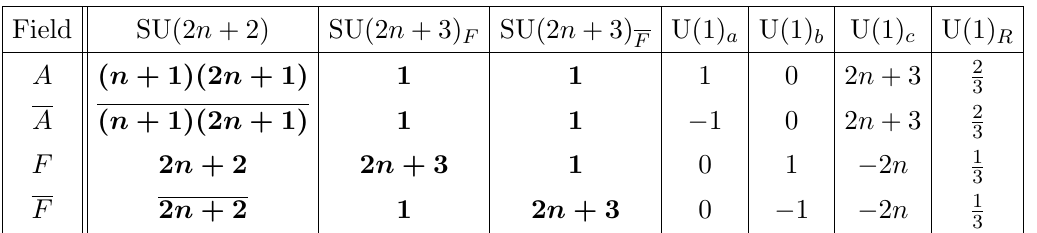
Table 3 . The (cid:12)elds appearing in the proposed dual of the R charges under the gauge and global